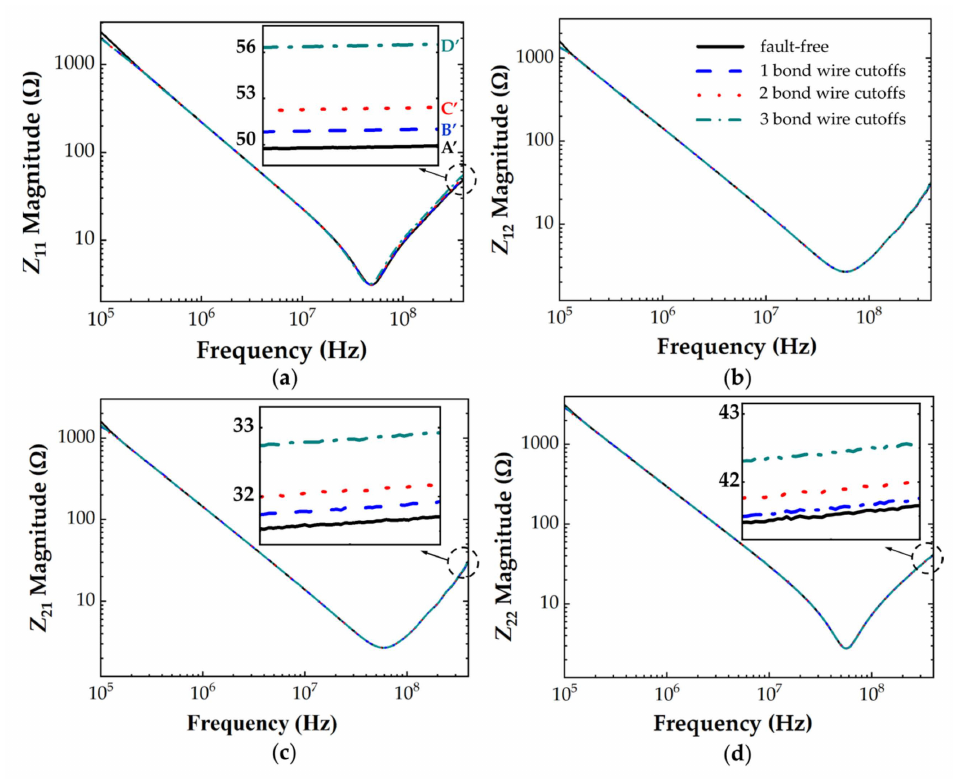
Figure 12. Z − parameters of C2M0160120D with different cutoff numbers of bond wires (A’ = 49.38 Ω , B’ = 50.60 Ω , C’ = 52.15 Ω , D’ = 56.66 Ω ). ( a ) Z 11 , ( b ) Z 12 , ( c ) Z 21 , ( d ) Z 22